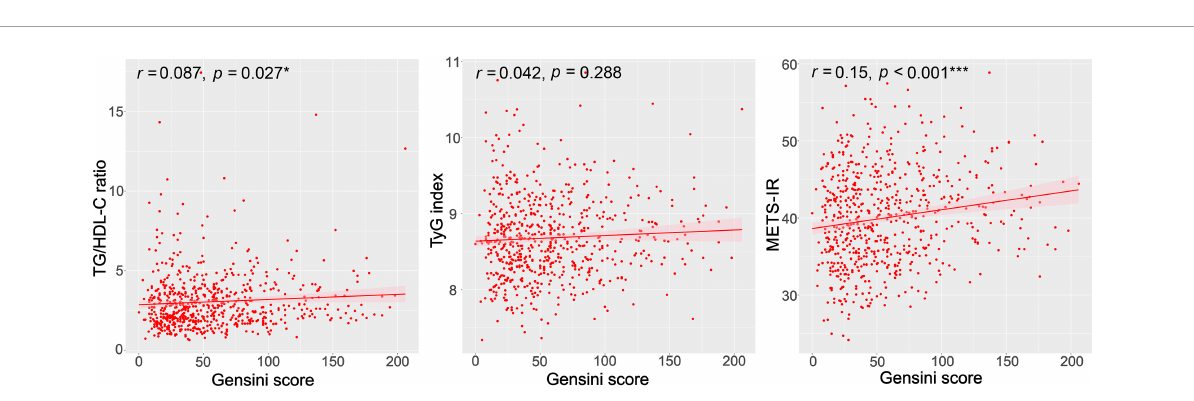
FIGURE2 Correlations between the TG/HDL-C ratio, TyG index, METS-IR, and the GS. GS, Gensini score; TG/HDL-C ratio, the ratio of triglycerides to high-density lipoprotein cholesterol; TyG index, triglyceride and glucose index; METS-IR, metabolic score for insulin resistance. * p < 0.05; *** p <